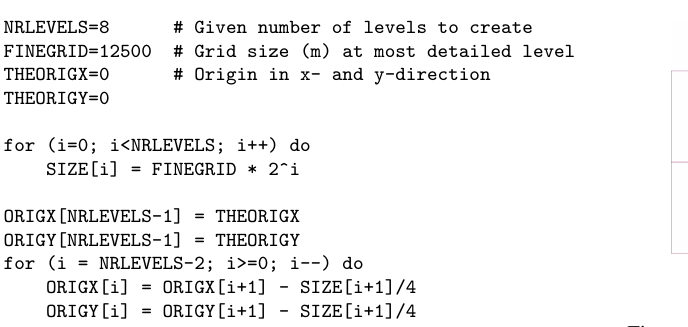
Figure 3: Distribution of the edges over the fields of the